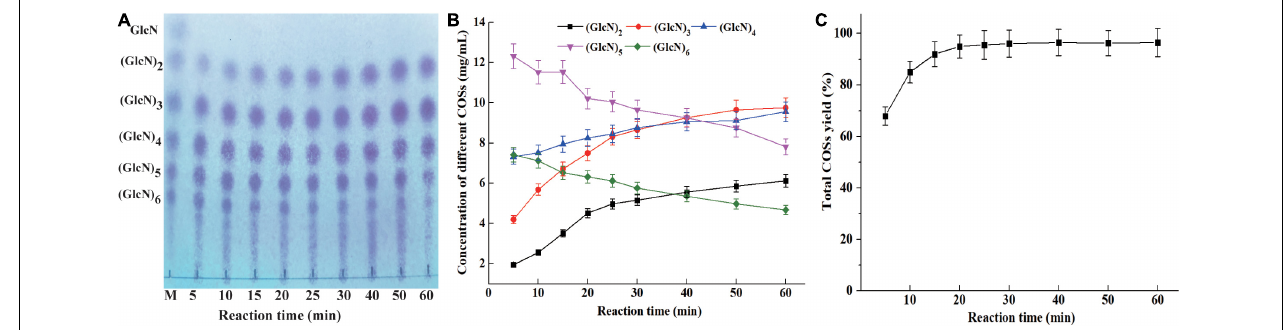
FIGURE 6 | Analysis of hydrolysates of 4% colloidal chitosan with 9 U/ml crude CsnBm at different reaction times. (A) TLC analysis of hydrolysates from different reaction time. M, marker sugars containing GlcN, (GlcN) 2 , (GlcN) 3 , (GlcN) 4 , (GlcN) 5 , and (GlcN) 6 . (B) The concentrations of COSs at different reaction time. (C) Total COSs yield of 4% colloidal chitosan at different reaction time. TABLE 3 | Enzymatic conversion of chitosan to COSs by chitosanases. Microorganism